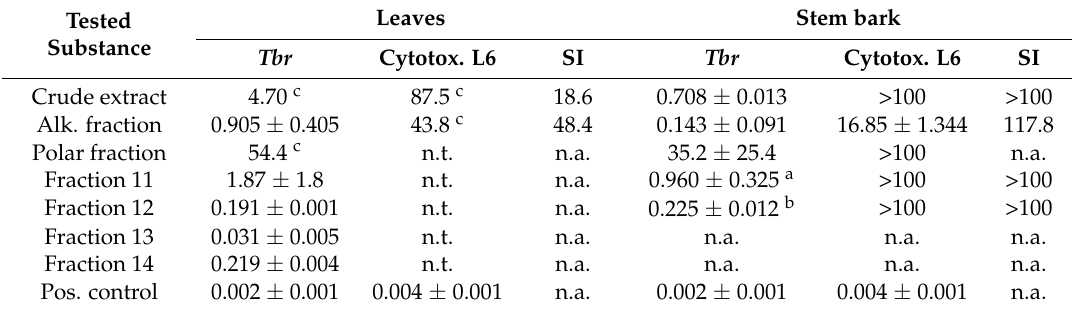
Table 1. In vitro anti-trypanosomal and cytotoxic activity of crude extracts, alkaloid fraction and CC fractions of H. africana leaves and stem bark.